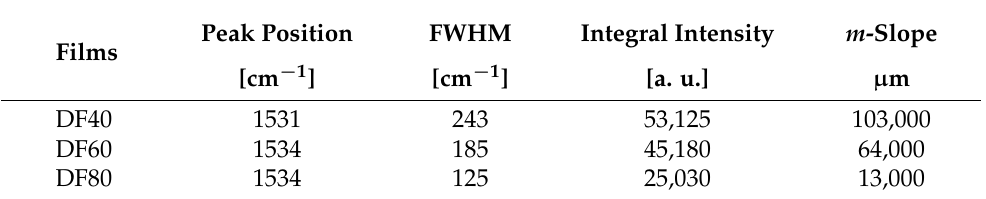
Table 2. The G-band parameters and photoluminescence